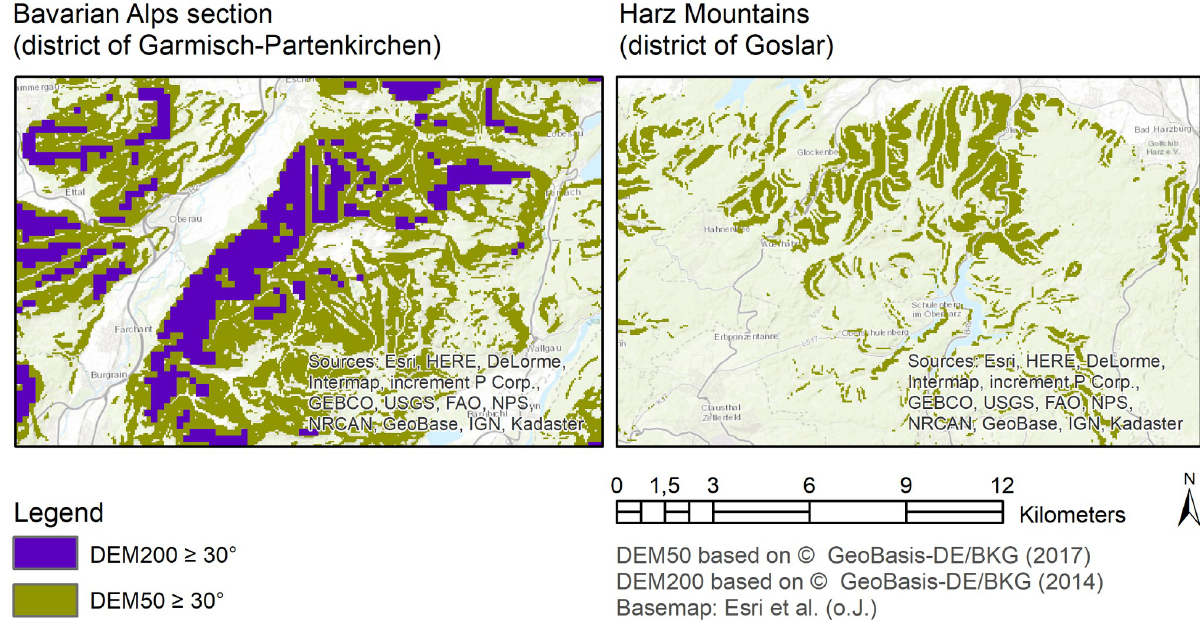
Fig 5. Comparison of the two elevation models DEM50 and DEM200 with a slope � 30˚ illustrated by the example of a Bavarian Alps section (left) and a Harz section (right).